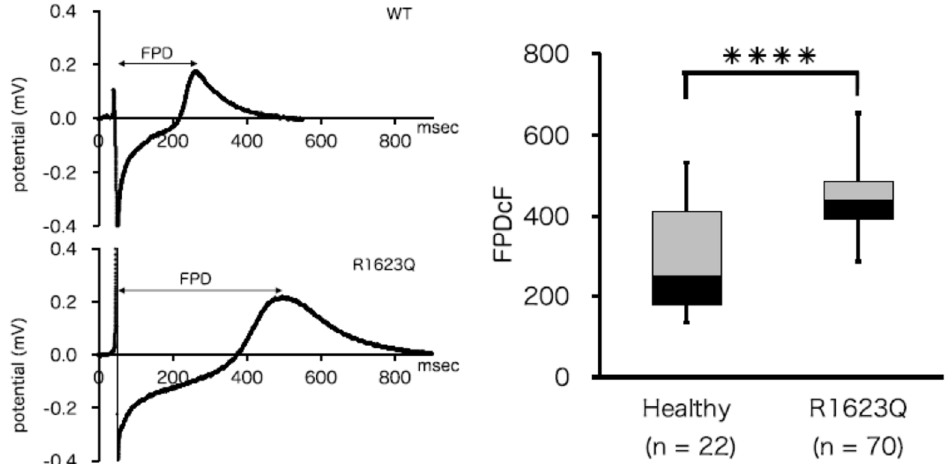
Figure 1. Electrophysiological analysis of induced pluripotent stem cells (iPSCs)-derived cardiomyocytes (CMs). (Left panel) Representative baseline field potential waveforms in iPSC-CMs from healthy volunteers (upper) and LQT syndrome type 3 (LQT3) patients with the R1623Q SCN5A mutation (lower). (Right panel) The field potential duration corrected by Fridericia’s correction formula (FPDcF) of R1623Q mutation-harboring hiPSC-CMs was significantly larger than that of WT iPSC-CMs (from [49]).**** p < 0.0001.